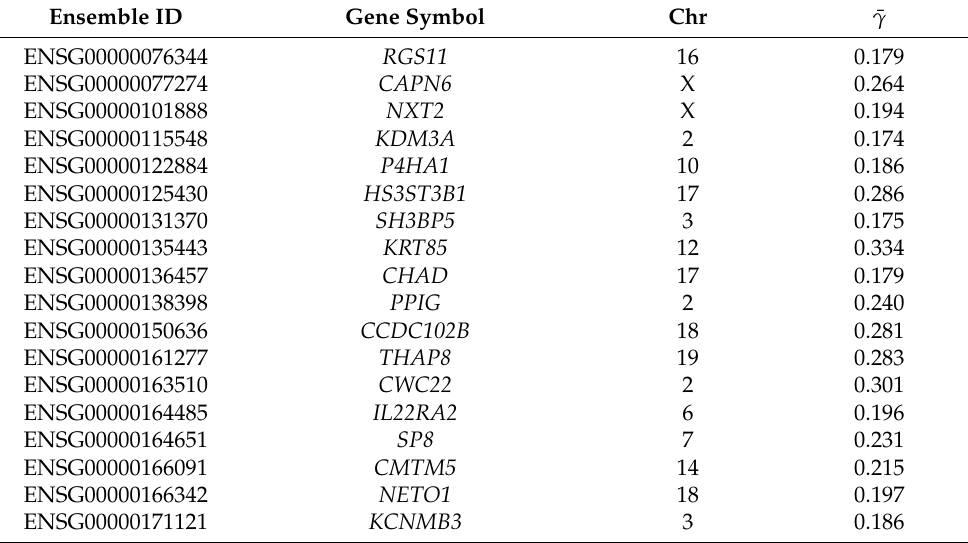
Table 1. Transcripts significant from the regression-based variable inclusion indicator